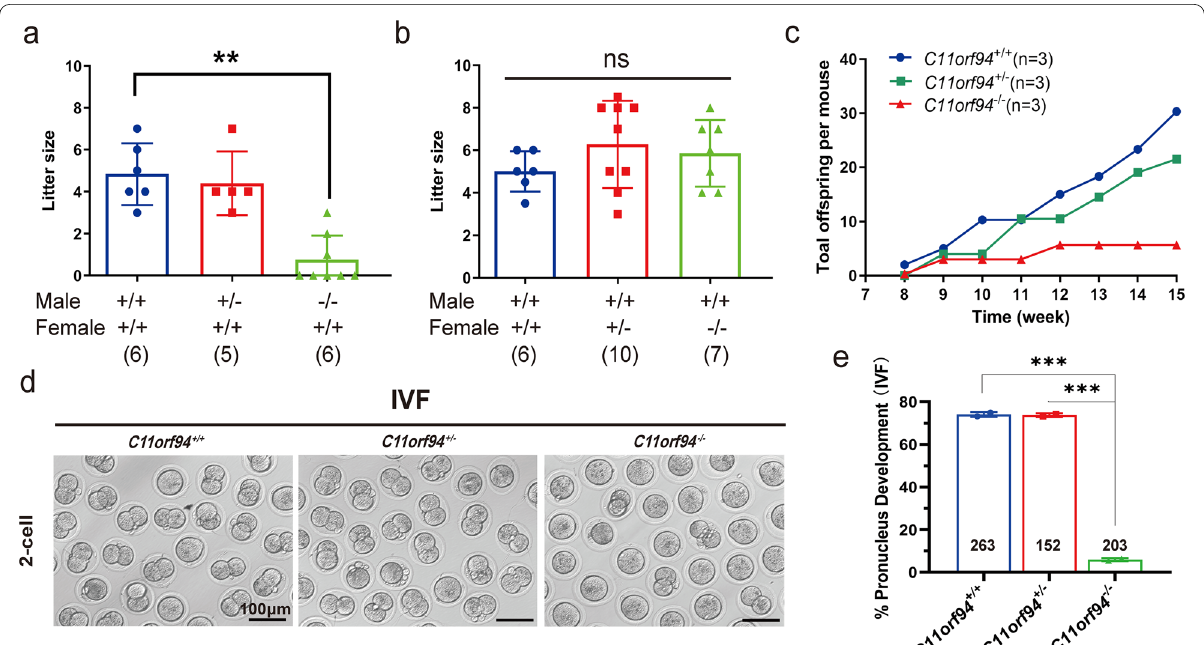
Fig. 4 In vitro and in vivo sterility of C11orf94 − / − mice. a Litter size of crosses between C57BL/6 females ( n 6) and C11orf94 − / − , C11orf94 ± , ≥ C11orf94 + / + males ( n 6). Values indicate mean SEM. The numbers in brackets represent the number of mating pairs (**, p < 0.01). b Litter size ≥ ± of crosses between C57BL/6 male mice ( n 6) and C11orf94 −/− , C11orf94 ± , C11orf94 + / + females ( n 6). Values indicate mean SEM. The numbers ≥ ≥ ± in brackets represent the number of mating pairs. ns: no significance. c Total offspring per mouse over time for the three genotype male mice. d Sperm sterility with cumulus-intact oocytes by in vitro fertilization test. Sperm exact from the cauda epididymis of three genotype mice and cumulus-intact oocytes derive from wild type C57BL/6 female mice. Here is representative diagram of 2-cell in the fertilized oocyte development. e The ratio of pronucleus development to total oocytes. There was significant difference between C11orf94 − / − males and C11orf94 + / + or C11orf94 . ± males (***, p <